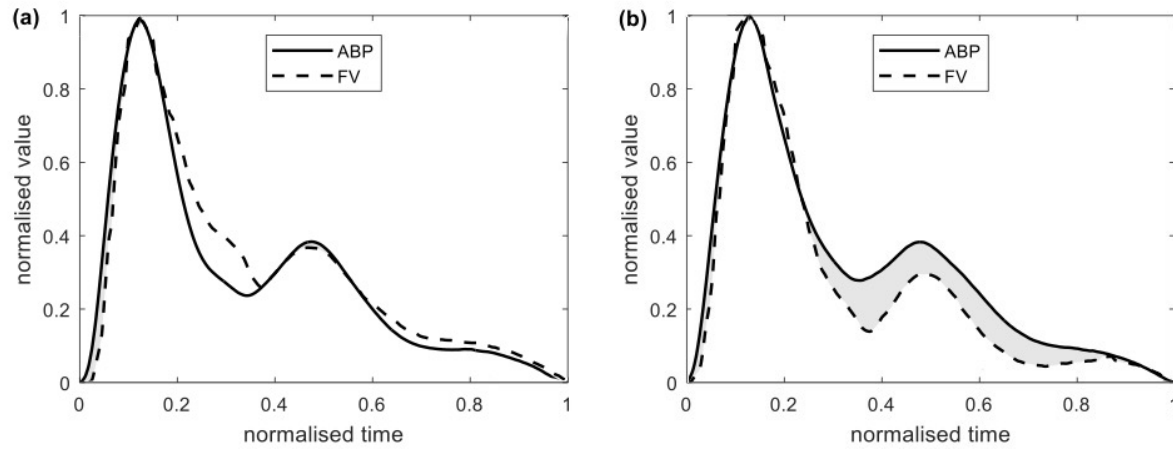
Figure 3. Representative cycles of ABP and FV waves at baseline ( a ) and during a plateau wave ( b ), obtained after the procedure of time alignment and normalisation described in the Materials and Methods section. The area where the normalised value of FV is lower than the one of ABP is shaded.